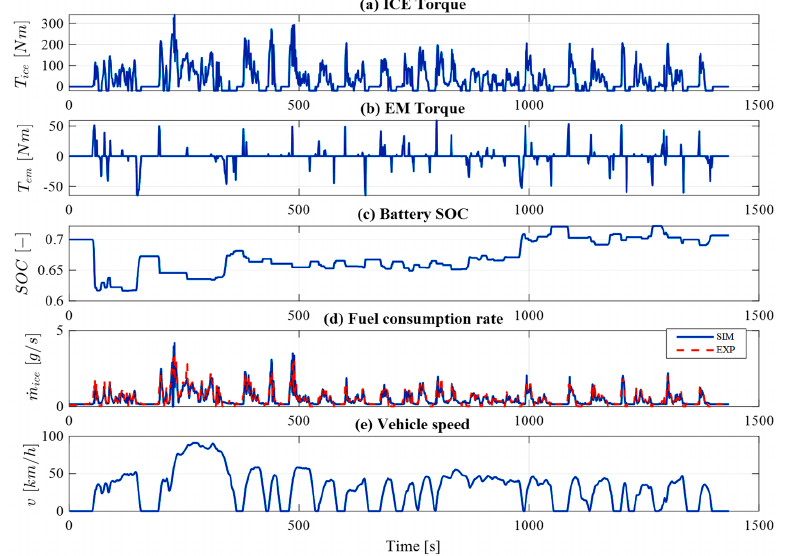
Figure 18. Simulation results with the on/off penalty on the temperature on UDDS driving cycle: ( a ) ICE torque, ( b ) EM torque, ( c ) Battery SOC, ( d ) Fuel consumption rate and ( e ) Vehicle speed.